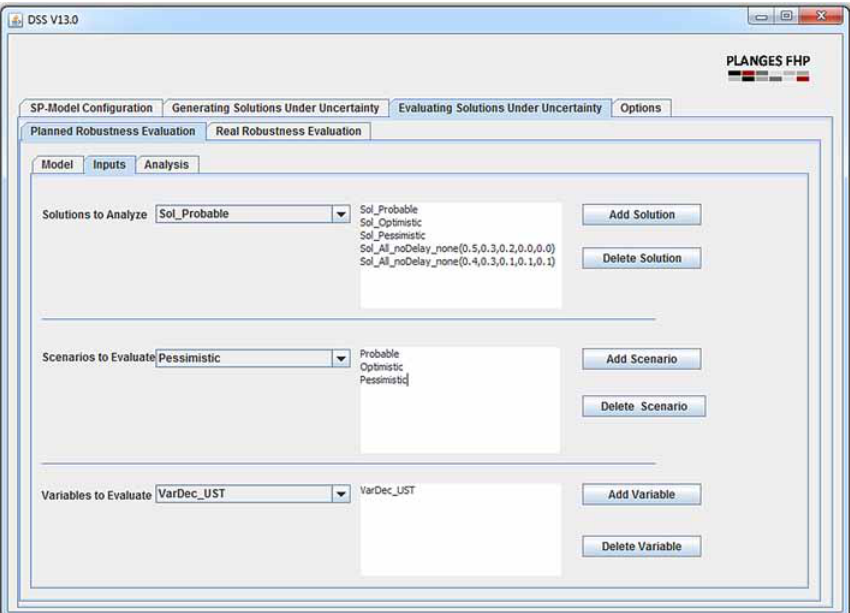
Fig. 7. The “Planned Robustness Evaluation”